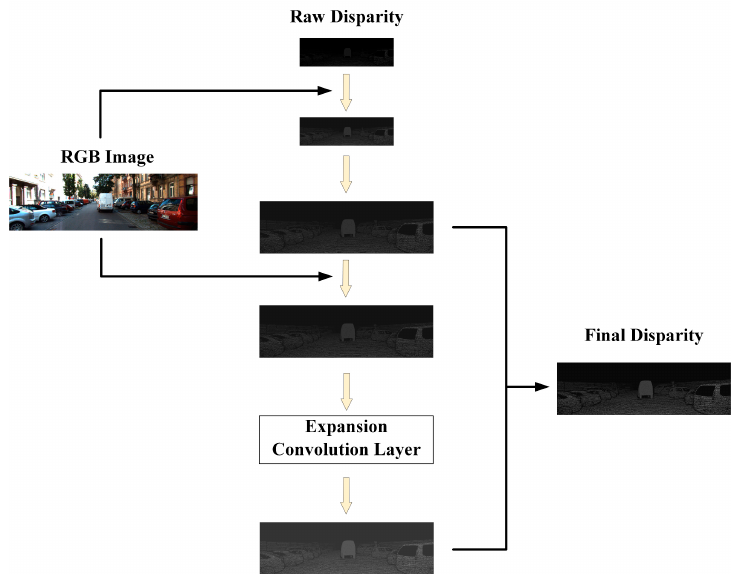
Figure 7. Our edge-guided refinement network. The RGB image is used to guide the 2D convolution process of the raw disparity image with two layers, and the expansion convolution is used to enhance the fusion effect. In this way, the fine disparity image is obtained in the end.